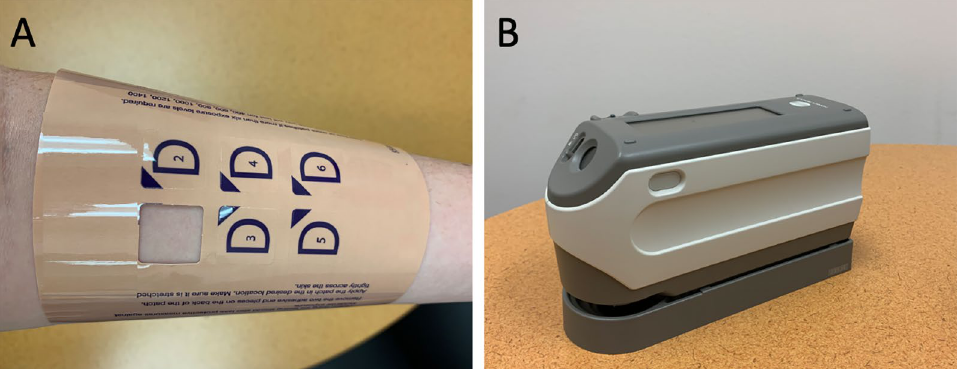
Figure 1. PI-MED Materials and Equipment. ( A ) six-aperture dose testing patch (purchased from The Daavlin Company) used to administer different UV dosages across six exposure sites on the skin. ( B ) handheld spectrophotometer (purchased from Konica Minolta) used to assess erythema by measuring skin